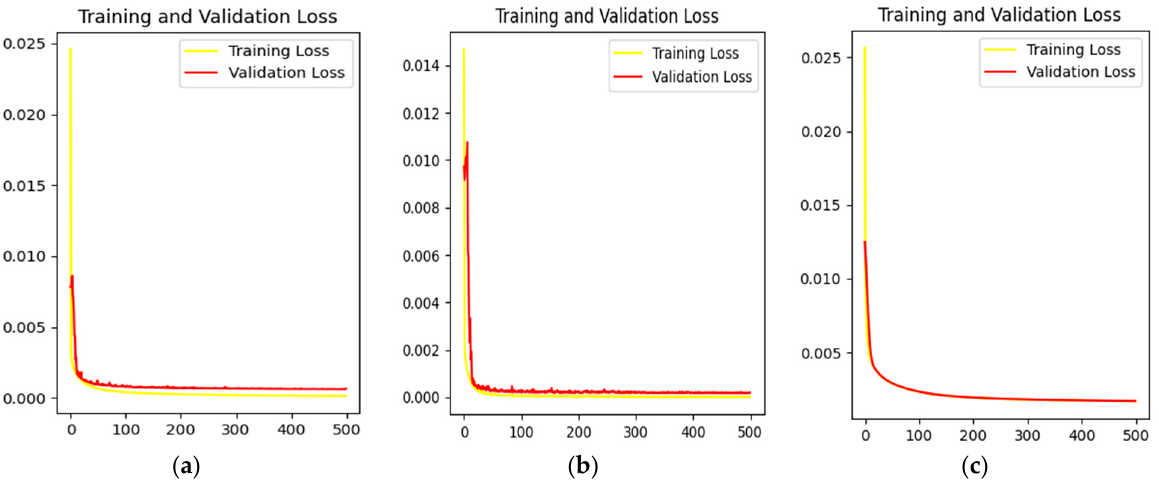
Figure 8. ( a ) Loss curve of training set and veri fi cation set when Adagrad is used as optimizer; ( b ) loss curve of training set and veri fi cation set when Adam is used as optimizer; ( c ) loss curve of training set and veri fi cation set when SGD is used as optimizer.